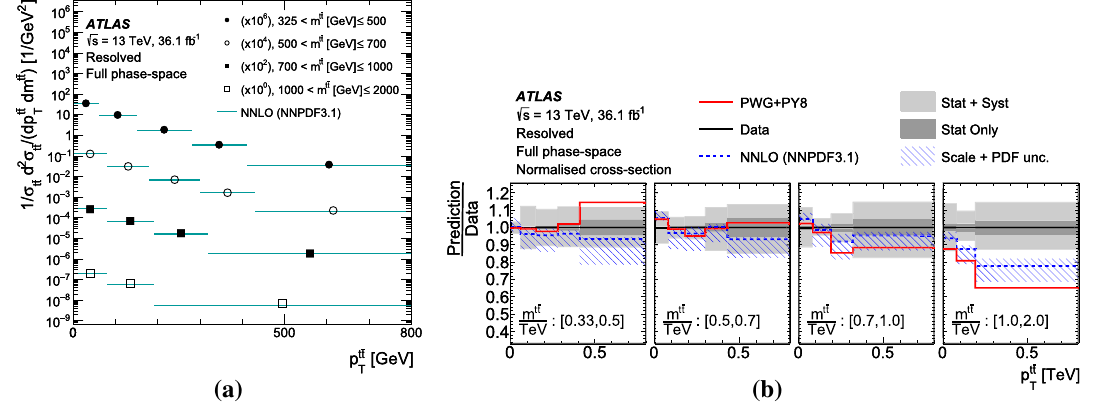
Fig. 62 a Parton-level normalised differential cross-section as a func- tion of p t ¯ t in bins of m t ¯ t in the resolved topology compared with the T NNLO prediction obtained using the NNPDF3.1 NNLO PDF set. Data points are placed at the centre of each bin. b The ratio of the measured